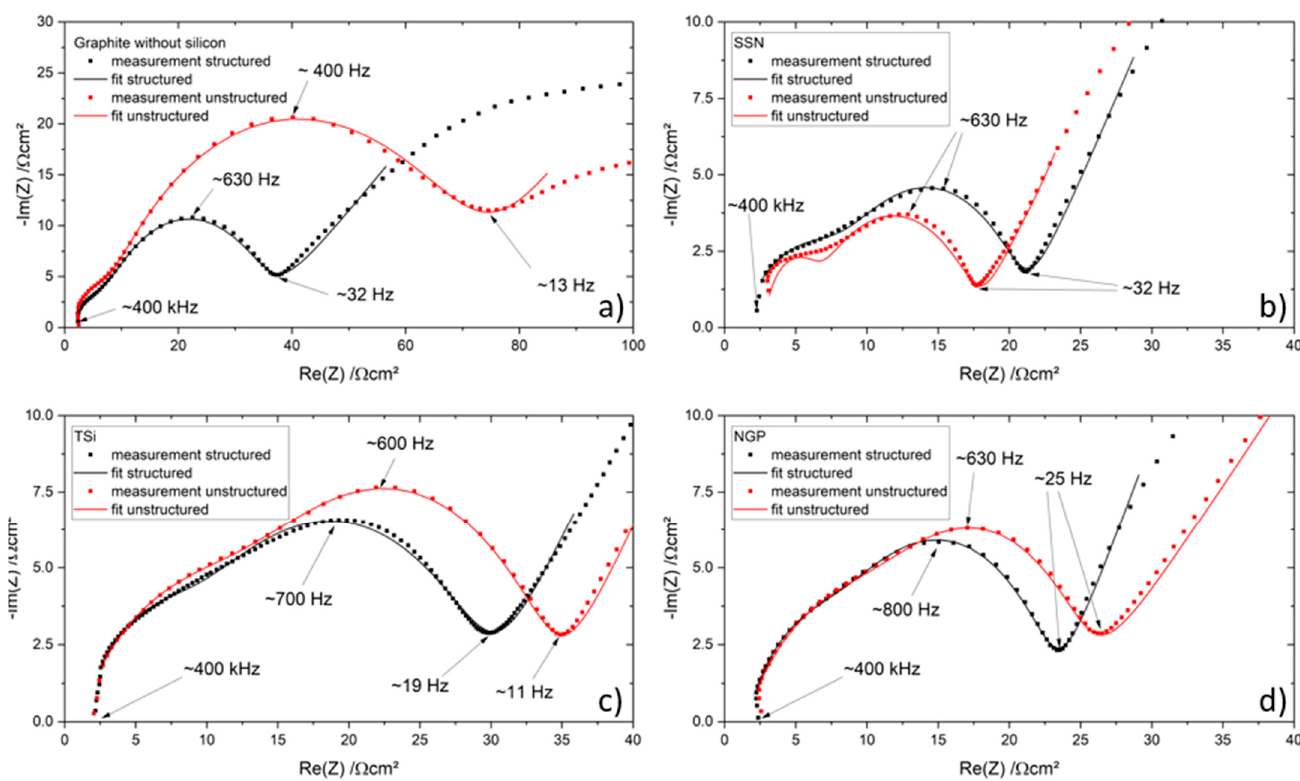
Figure 10. Electrochemical impedance spectra (Nyquist plots) of the coin cells with structured (black) and unstructured (red) electrodes and their corresponding fitting function: ( a ) pure graphite, ( b ) SSN, ( c ) TSi, and ( d ) NGP. Table 8. Resistances of the coin cells, extracted from Figure 10.